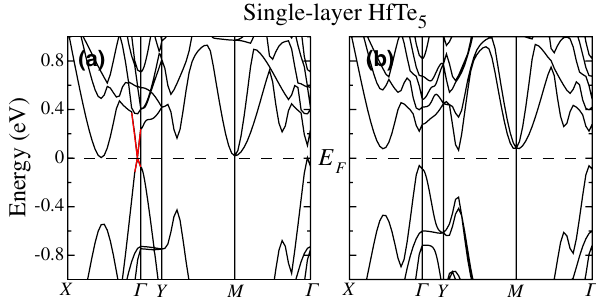
FIG. 8 (color online). The calculated band structures of single- layer HfTe 5 (a) without and (b) with SOC,